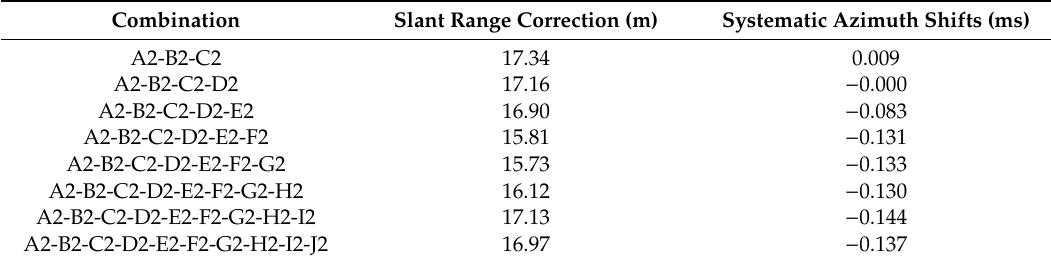
Table 4. Geometric calibration results for Calibration Group B (150 MHz and 24.4 µ s).